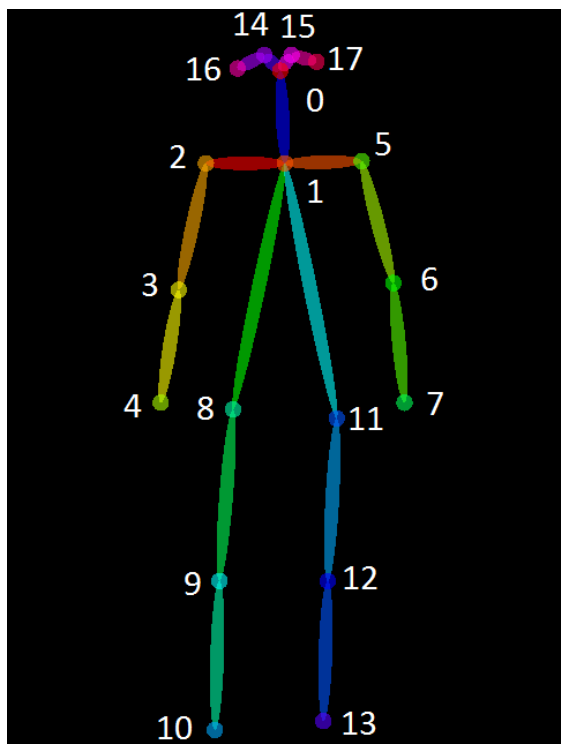
Figure 3. 18 keypoints estimated by the OpenPose